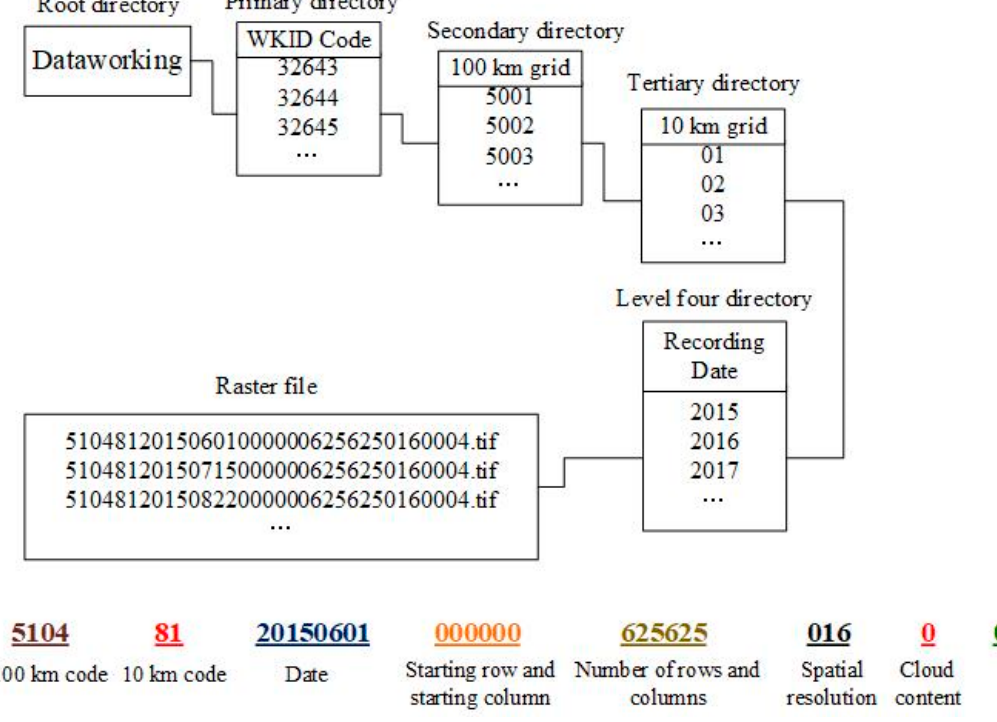
Figure 4. Raster dataset clean and reconstitution multigrid (RDCRMG) coding rules and storage methods.